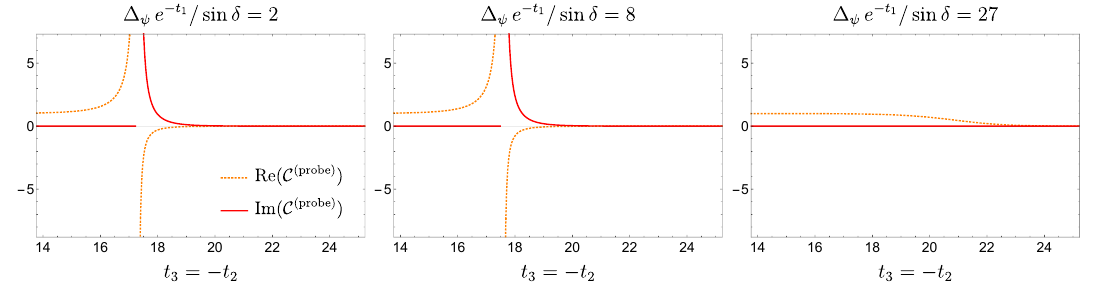
Figure 9 . The signal passing from the right to the left boundary through the traversable wormhole is given by − 2 i Im ( C ) . This plot shows the probe approximation. We fix the strength of the left-right coupling as g = 50 and vary the strength of the perturbation, which is parametrized by ∆ − t 1 / sin δ . For a mild collision (left figure) we observe a pole, indicating that information about ψ e the collision has traversed the wormhole. The signal of a strong collision (right figure) cannot be extracted. We set ∆ = ∆ = 0 . 7 , G = 10 − 8 . The scrambling time is t φ j